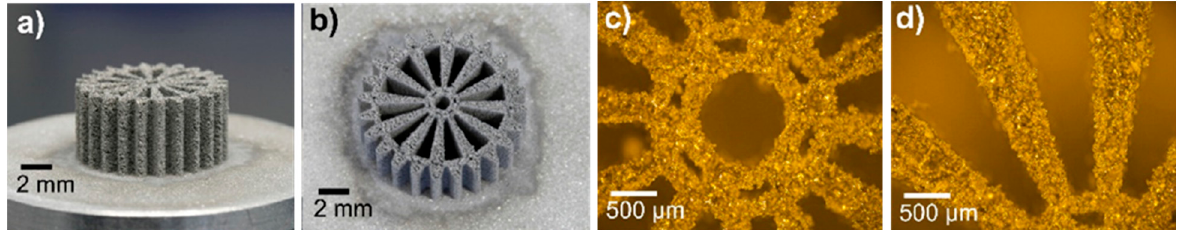
Figure 24. ( a ) Samples fabricated at different scan velocities (0.2, 0.3, 0.5 and 0.7 m/s, from left to right); Printed structure’s microscopic images with a scan velocity of ( b ) 0.3 m/s and ( c ) 0.7 m/s [60].